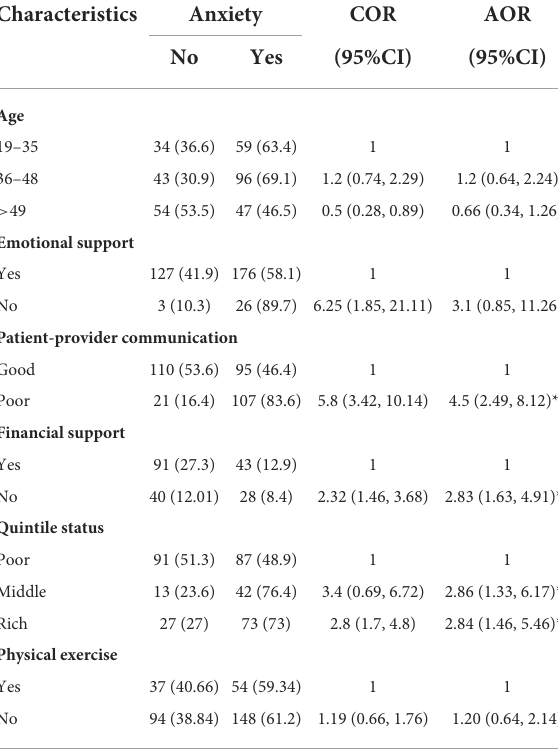
TABLE 4 The result of logistic regression for depression after controlling the effect of confounding factors among patients with breast